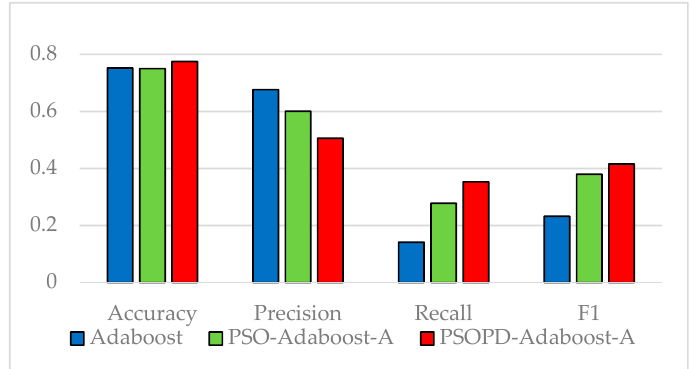
Figure 11. Performance Comparison of the AdaBoost, PSO-AdaBoost-A, and PSOPD-AdaBoost-A on JM1 Dataset.